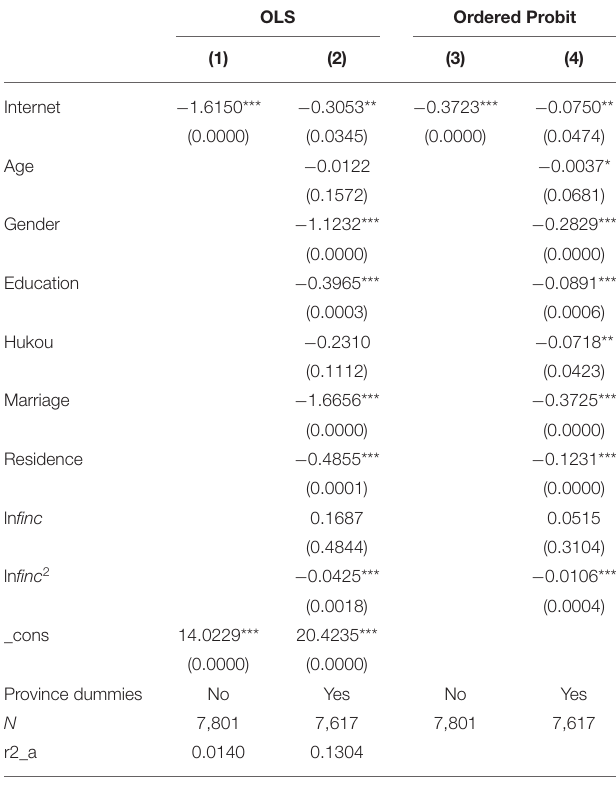
TABLE 2 | Results of the ordinary least square and ordered probit methods.